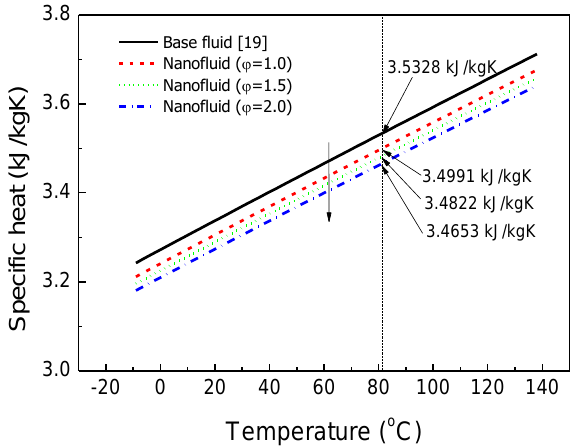
Figure 8. Specific heat modeling of the base fluid and a Al 2 O 3 nanofluid.